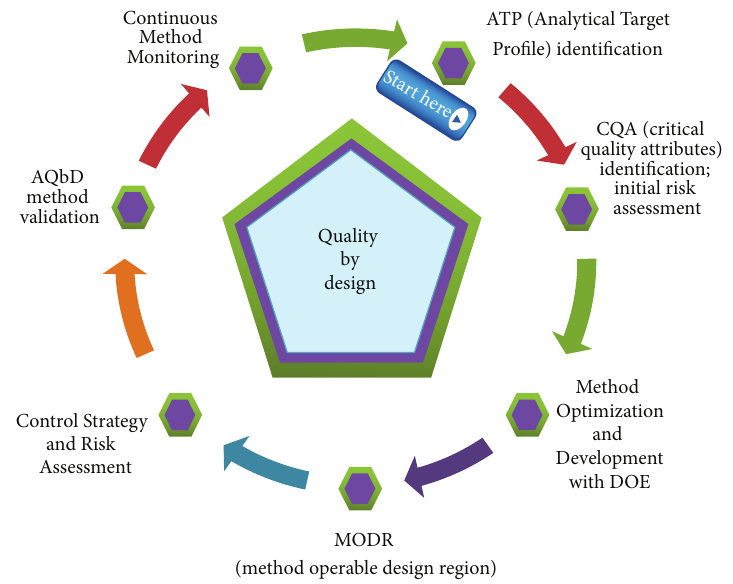
Figure 1: AQbD tools and life cycle.